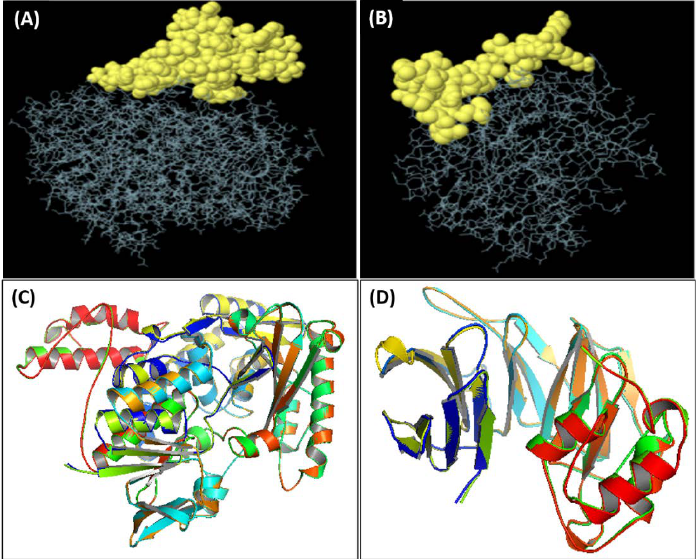
Figure 2. ( A ) Discontinuous epitopes of phytoene dehydrogenase, ( B ) discontinuous epitopes of the hypothetical protein, ( C ) superimposed raw and refined models of phytoene dehydrogenase, ( D ) superimposed raw and refined models of the hypothetical protein. ( D ) superimposed raw and refined models of the hypothetical